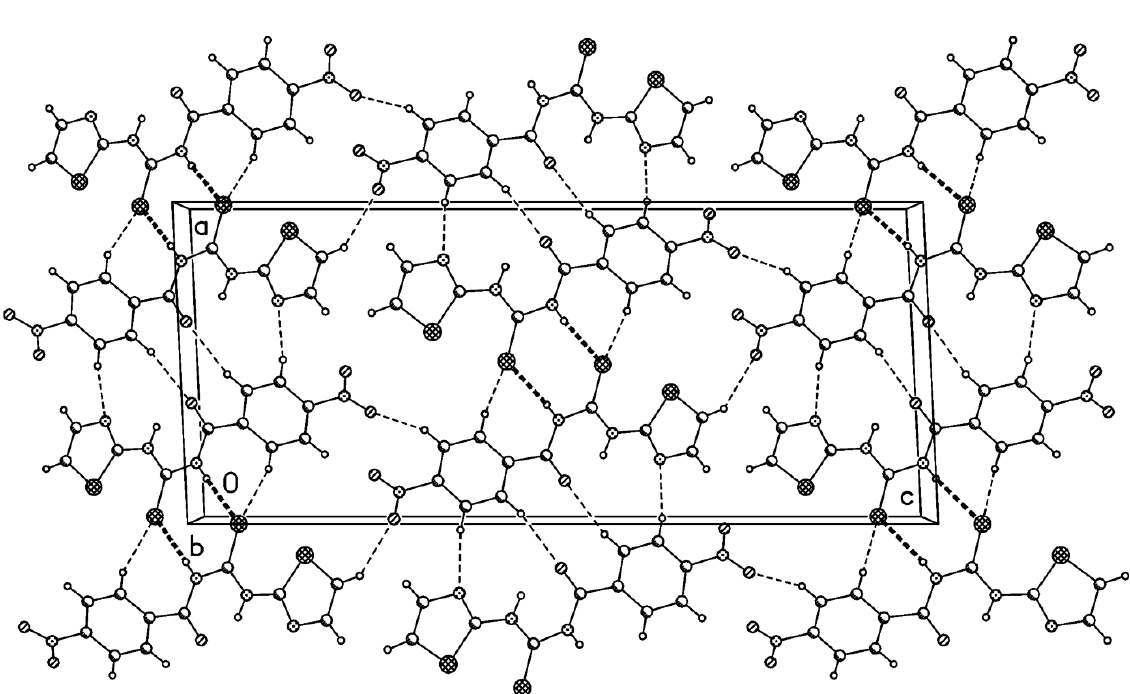
Figure 2. thiophene ring (1b), which have the log P 0.68 and 1.59 ± 0.65, respectively show higher antifungal